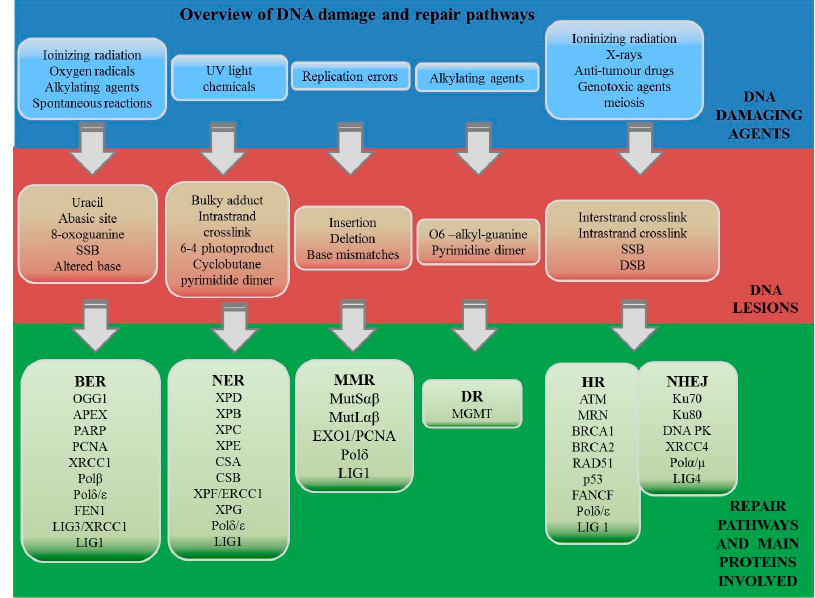
Figure 1. Overview of DNA damaging agents, induced DNA lesions, and their repair pathways (BER—base excision repair, NER—nucleotide excision repair, MMR—mismatch repair, DR—direct repair, NHEJ—non-homologous end-joining; and HR—homologous recombination). Shortcuts are explained in the abbreviation section.